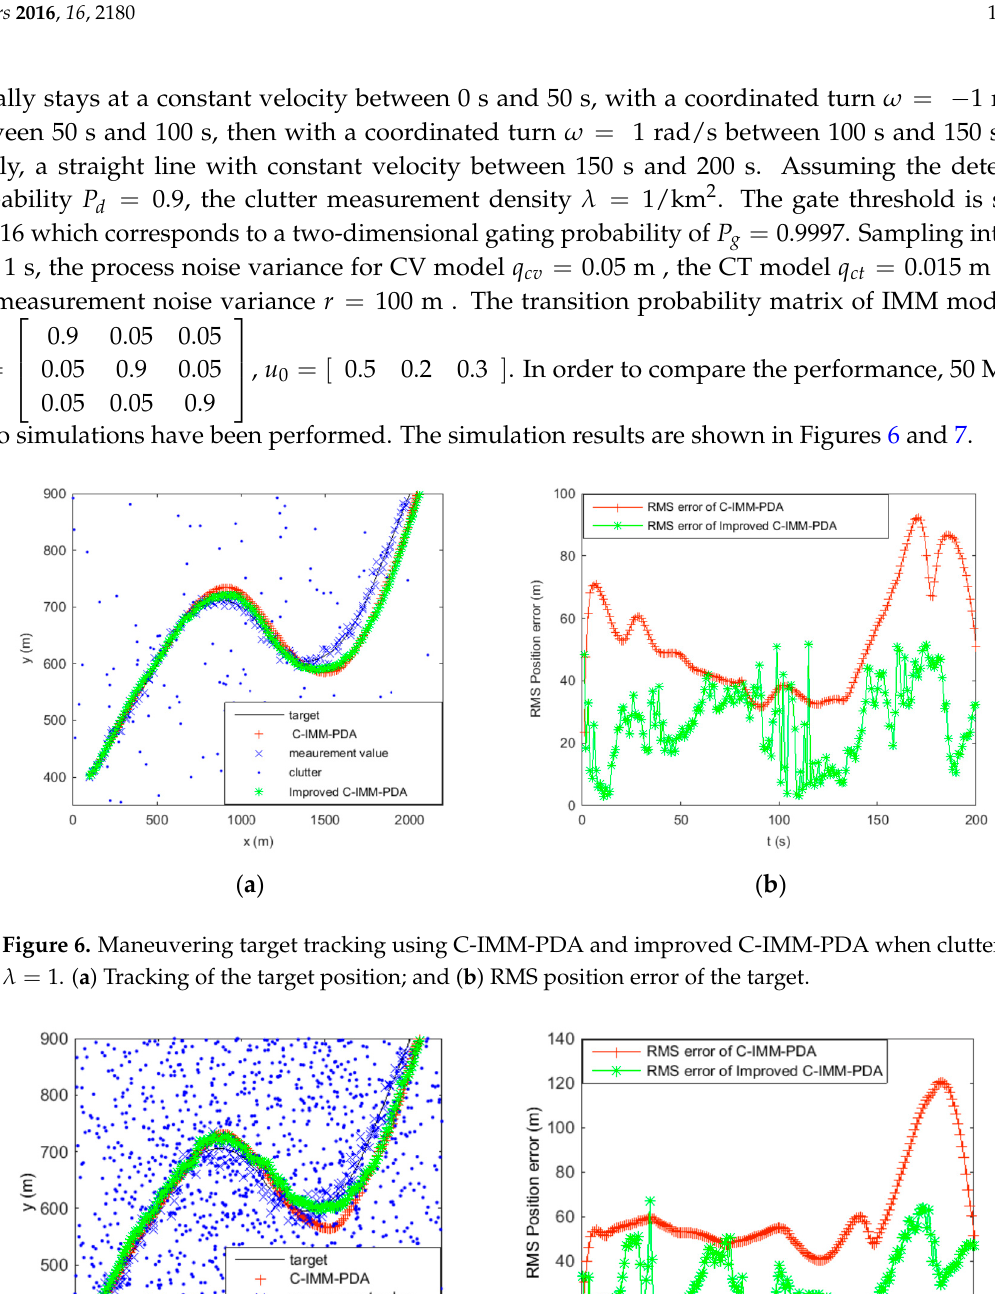
( b ) Figure 5. Tracking two crossing targets using PDA and improved PDA when clutter 5   . ( a ) Tracking of the target position; and ( b ) RMS position error of the target. 4.3. Simulation and Analysis of Maneuvering Target Tracking In this section, the performance of the proposed algorithm is evaluated and compared with the